Question: What does this figure show? Answer in one sentence.
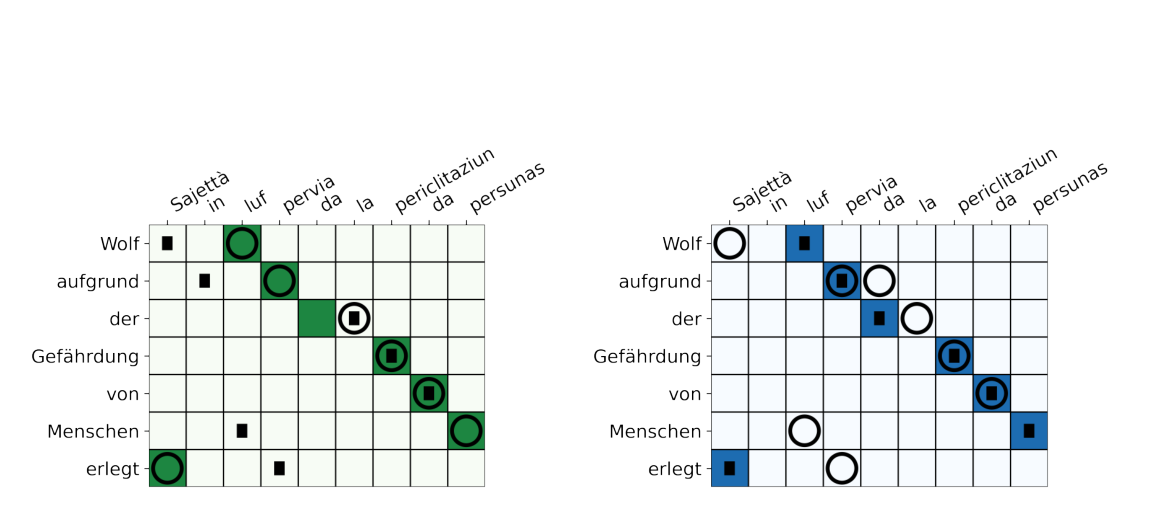
Answer: Example for the clear improvement after fine-tuning. Green: eflomal (boxes) vs. SimAlign (circles); Blue: awesome-align (circles) vs. after fine-tuning (boxes). The dark green/blue squares represent the gold alignments.